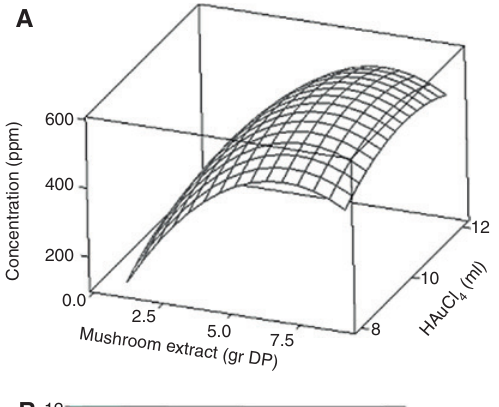
Figure 5: Overlaid contour plot of AuNPs λ with acceptable levels as function of MEC (g/100 ml) and amount of HAuCl 4